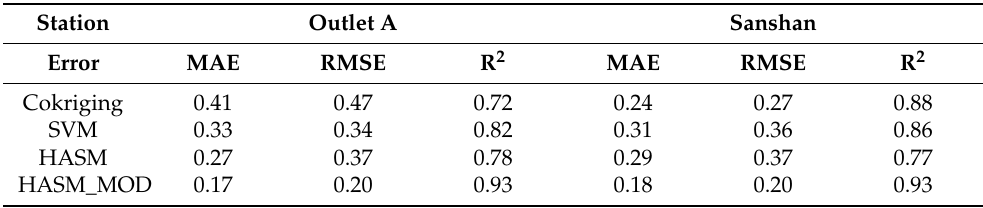
Table 2. Errors obtained with different